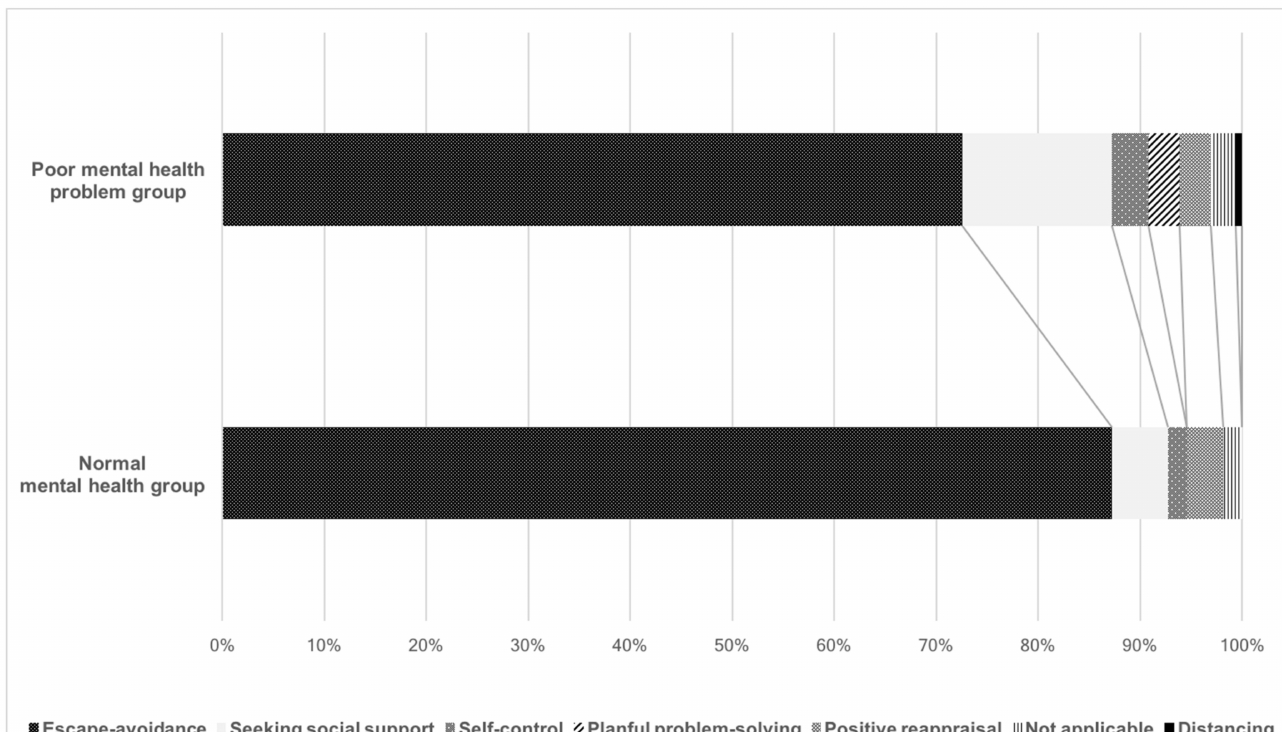
Figure 1. Coping strategies classified using descriptive data according to differences in mental health